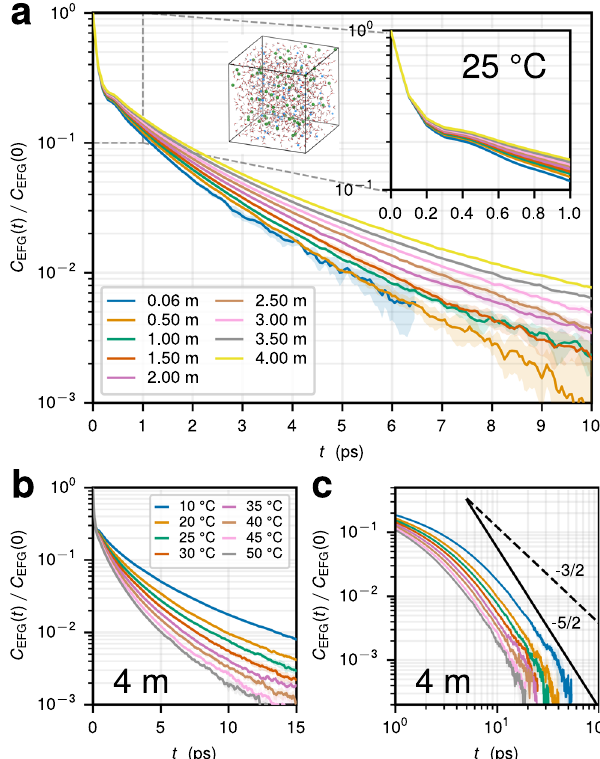
Fig. 2 | Relaxation of EFG fl uctuations. a Normalized autocorrelation functions C t )/ C EFG ( EFG (0) of the EFG at the position of a Na + ion obtained using classical MD simulationsfordifferentsaltconcentrations c at T =25°CinaqueousNaClsolutions ( c increases from bottom to top). Qualitatively similar trends are found for other concentrations and temperatures (see Supplementary Fig. 9). Insets in a highlight theshort-timebehavioroftheACFsfor t <1psandatypicalsystemcon fi gurationat c =4m(Na + andCl − ionsareblueandgreen,respectively). b Temperaturebehavior of C EFG ( t ) at c =4m ( T decreases from bottom to top). c Long-time behavior of t ) plotted on a double logarithmic scale at c =4m for different temperatures C EFG ( (the legend shown in b ). The black solid and dashed lines highlight a power-law scaling ~ t α with α = − 5/2 and α = − 3/2, respectively. See also Supplementary Fig. 15 for C EFG ( t ) multiplied by t 5/2 and t 3/2 . Shaded regions in a – c indicate standarderrors from multiple independent simulation